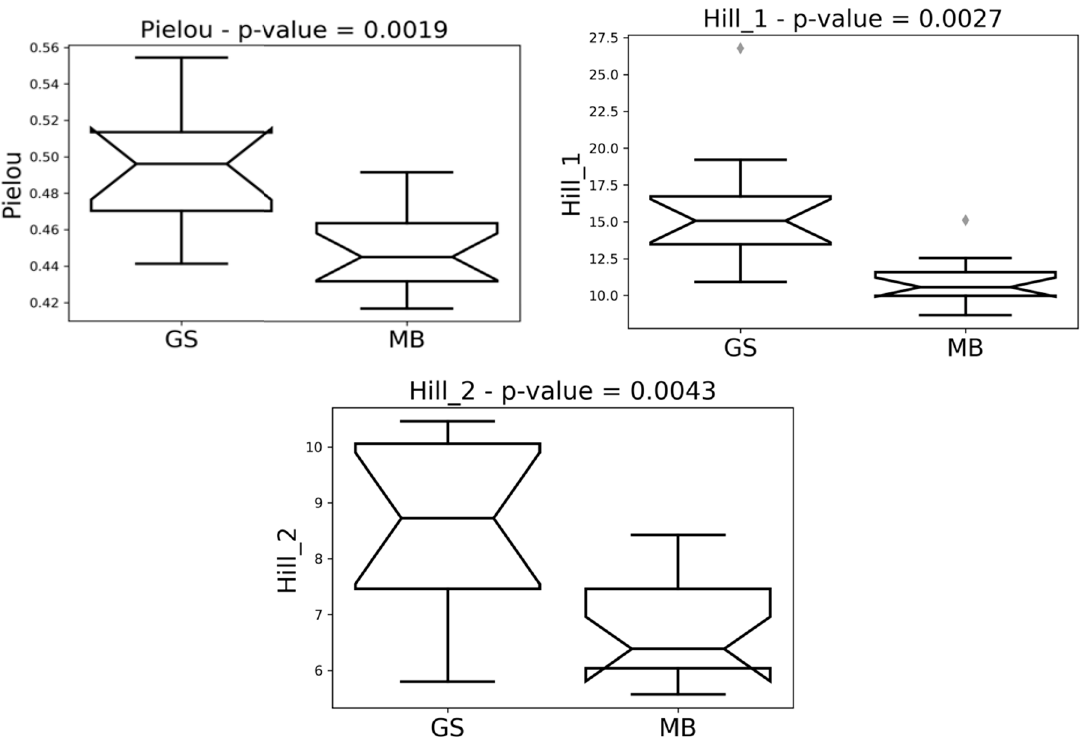
Figure 1. p values alpha diversity calculated by different indexes in the tested groups. GS = German Shepherd, MB = mixed breeds. Table 8. Index of median values in two